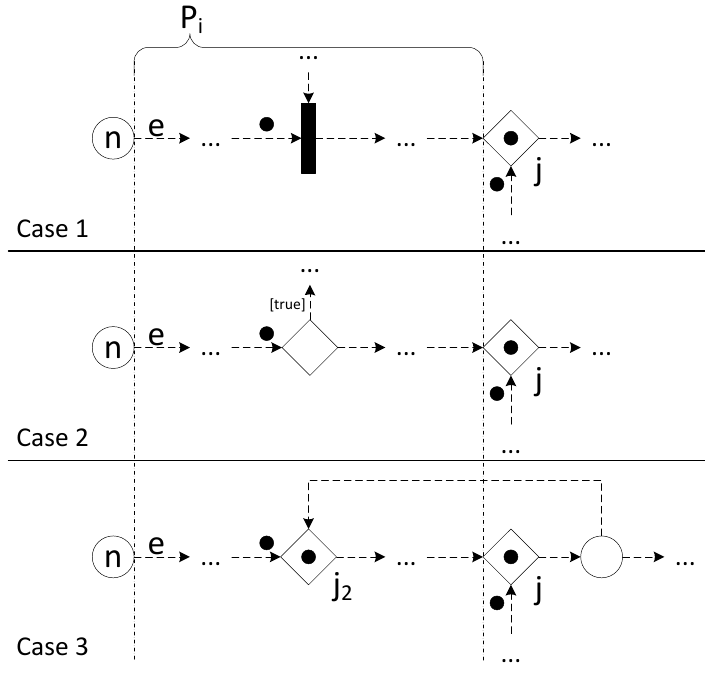
Figure 6. Cases how a token can never arrive at